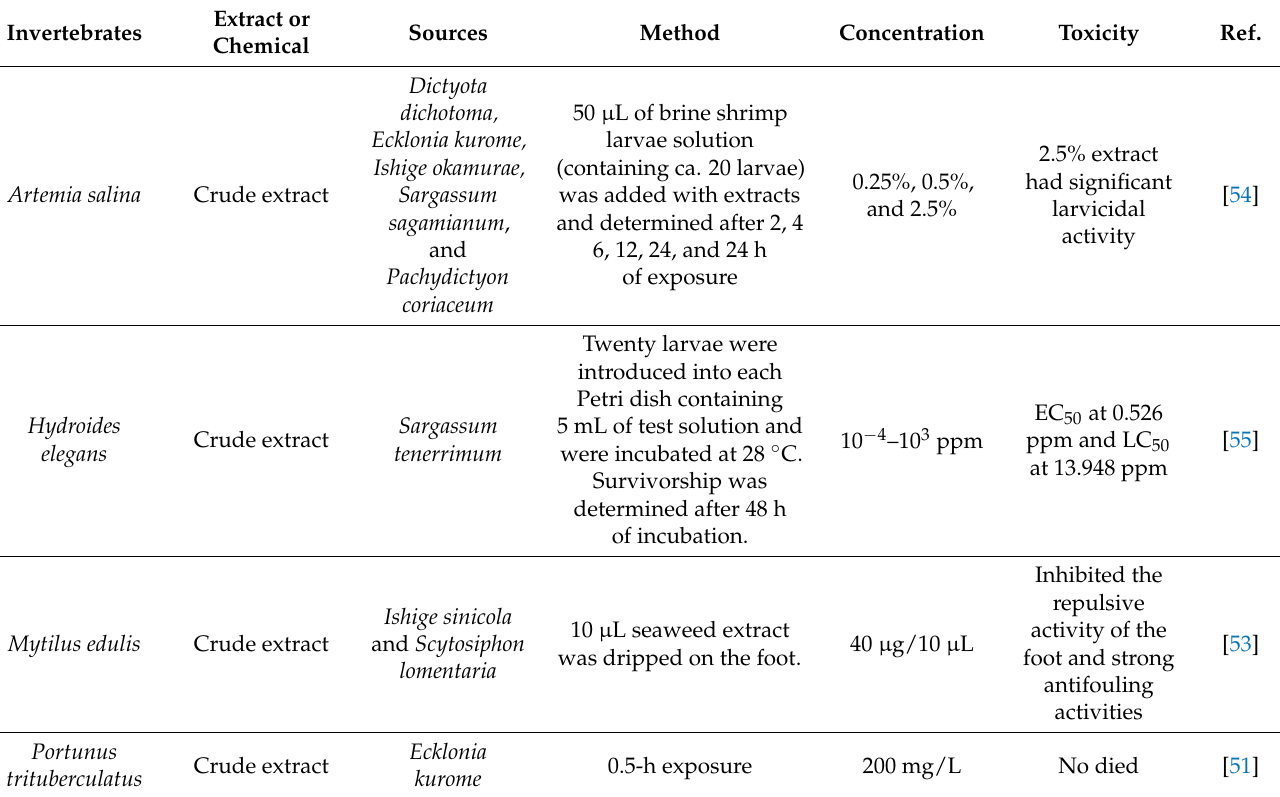
Table 4. Studies of safety and toxicity of phlorotannins extracted from brown seaweeds, as measured in invertebrates.